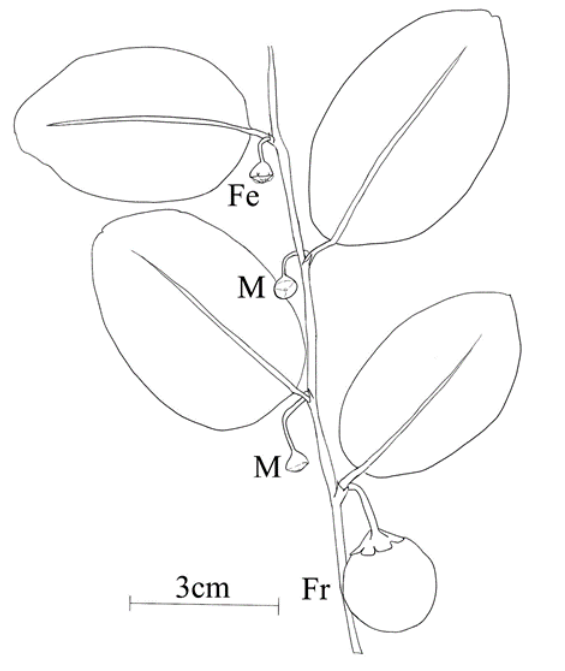
Figure 1. The male flowers (M), female flowers (Fe) and fruits (Fr) of Breynia oblongifolia